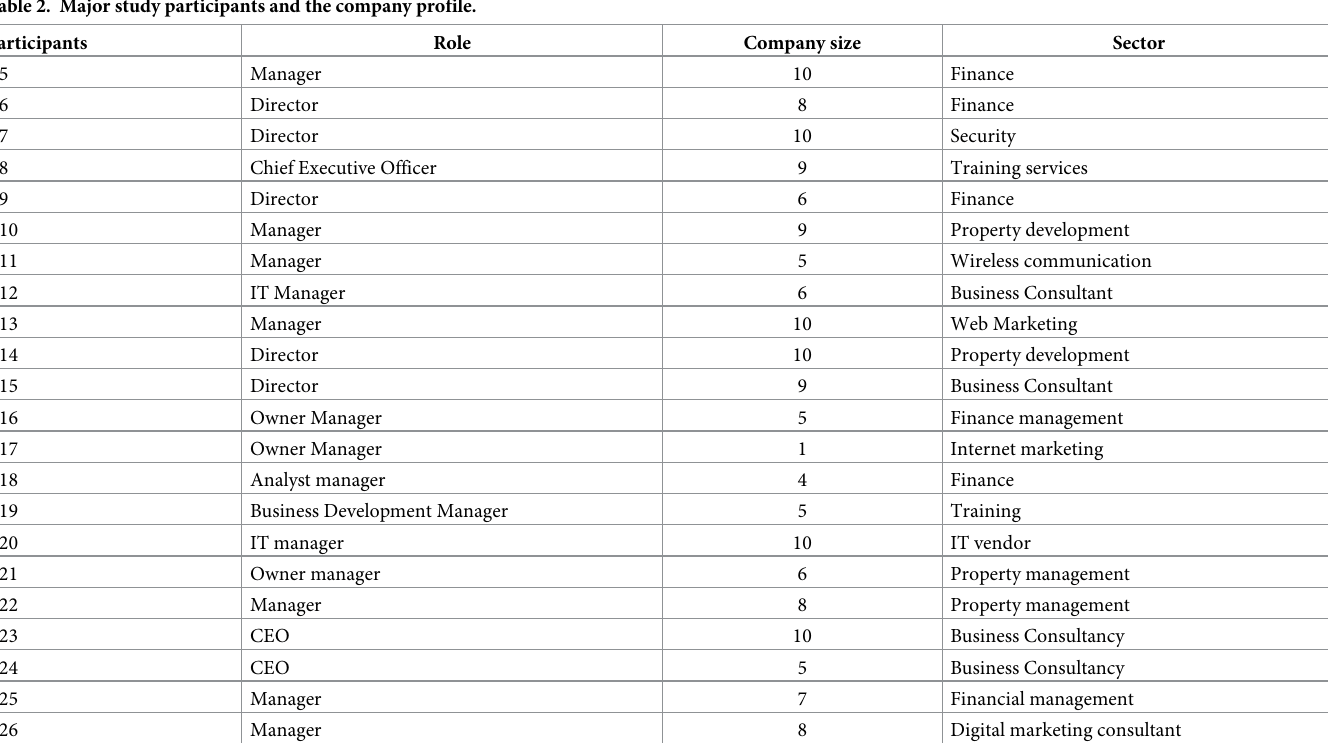
Table 2. Major study participants and the company profile.